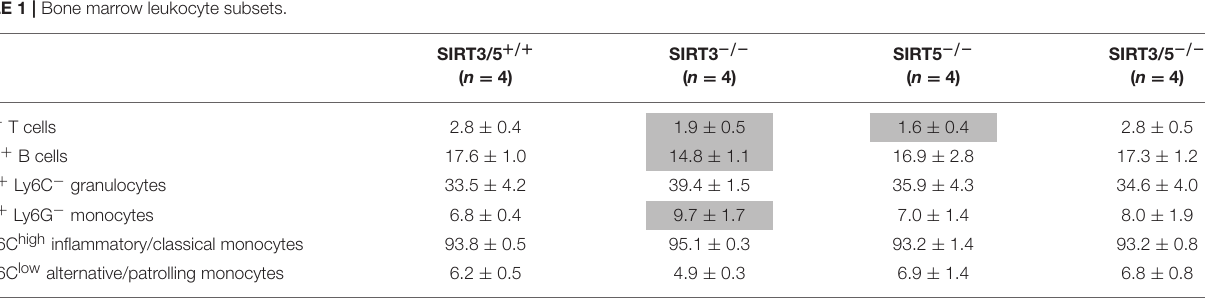
FIGURE 2 | SIRT3/5 deficient mice have a normal number of hematopoietic stem cells and progenitors in the bone marrow. (A) Number of CD45 + bone marrow cells per leg of SIRT3/5 + / + , SIRT3 − / − , SIRT5 − / − , and SIRT3/5 − / − mice aged 10–14 weeks. (B) Percentage of lineage negative, Sca1 positive, c-kit positive (LSK) cells, long-term (LT)-hematopoietic stem cells (HSC), short-term (ST)-HSC, multipotent progenitors (MPP), MPP2, MMP3, and MPP4 among BM cells. Data are means ± SD from eight mice. (C) Number of CD19 + , CD3 + , Ly6G + , Ly6C high , or Ly6C low cells per leg of SIRT3/5 + / + and SIRT3/5 − / − mice. TABLE 1 | Bone marrow leukocyte subsets.